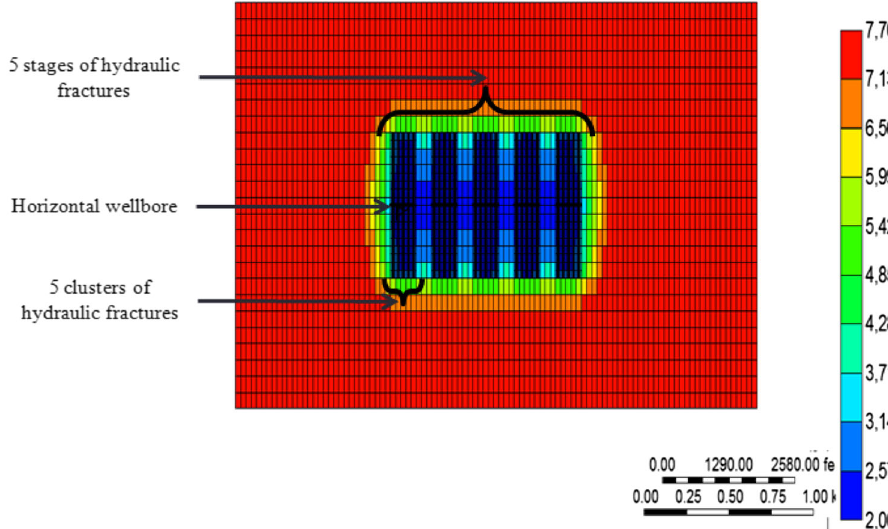
Fig. 8 Pressure distribution in one of the numerical simulation models and showing the number of fracture stages and the number of hydraulic fracture